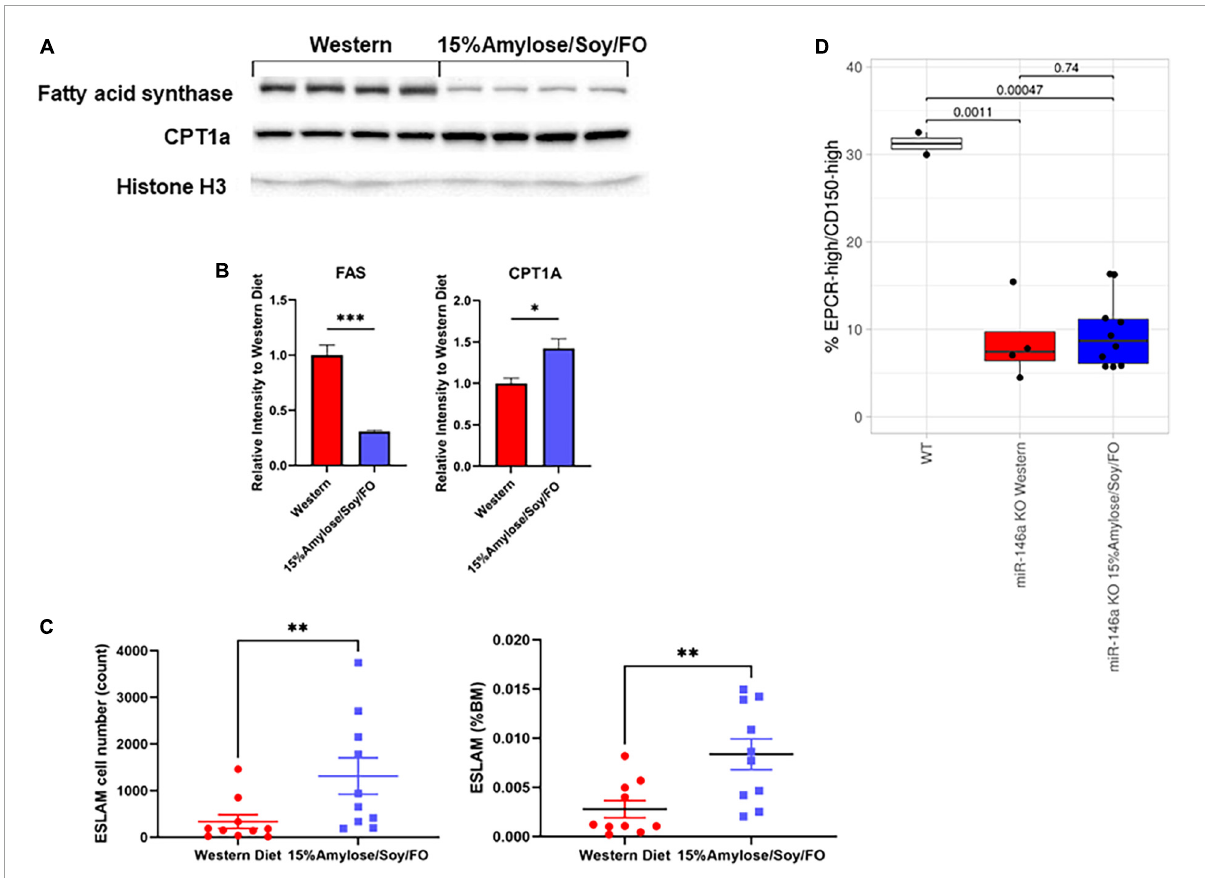
FIGURE6 A 15%Amylose/Soy/FO diet skews energy production to fatty acid/ketone body hydrolysis and increases the number of hematopoietic stem cells in 6-month-old miR-146a KO mice. (A) A Western blot showing FAS and CPT1 protein levels in the livers from 4 mice on a Western vs. 4 mice on a 15%Amylose/Soy/FO diet, taken at 6 months of age. Histone H3 was used as a loading control. (B) Densitometry plots of the FAS and CPT1 levels divided by the histone H3 levels. ∗ P < 0.05, ∗∗ P < 0.01, ∗∗∗ P < 0.001. (C) Flow cytometric analysis of primitive HSCs, based on EPCR+CD45+CD150+CD48- (ESLAM) markers, within the bone marrow of 6-month-old miR-146a KO mice on a Western vs. a 15%Amylose/Soy/FO diet. The data are shown as the mean ± the SEM from 8 mice on a Western and 10 mice on a 15%Amylose/Soy/FO diet and expressed as absolute numbers of HSCs per mouse (left panel) or percent of total nucleated bone marrow cells (right panel). (D) The level of EPCR hi /CD150 hi ESLAMs as a percent of total ESLAMs from mice with ESLAMs ≥ 125 events. P -values from t -test analysis were expressed between the groups being